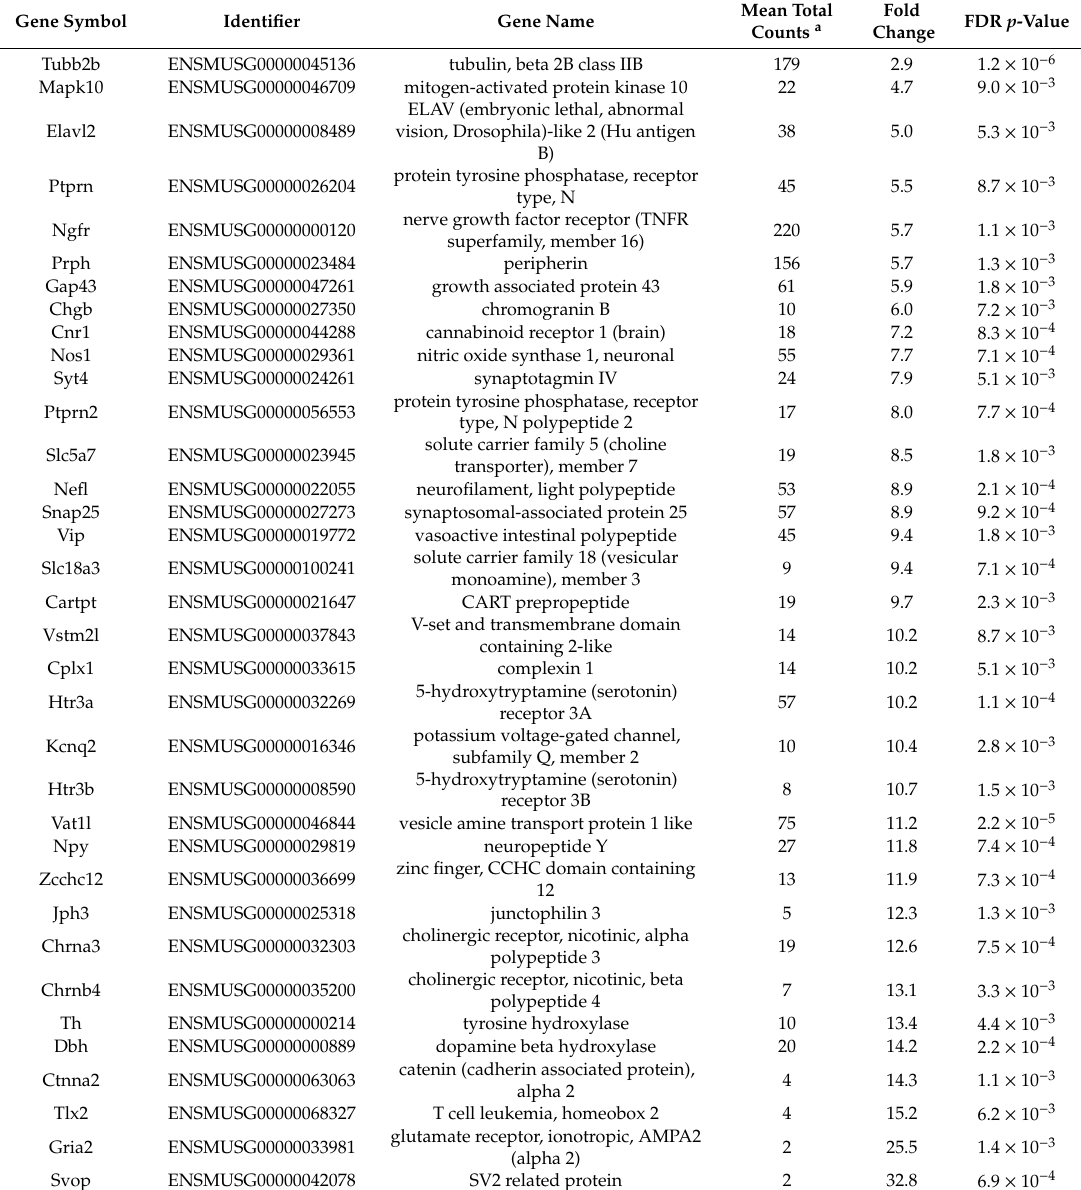
Table 5. Di ff erentially expressed genes specific for or associated with neural